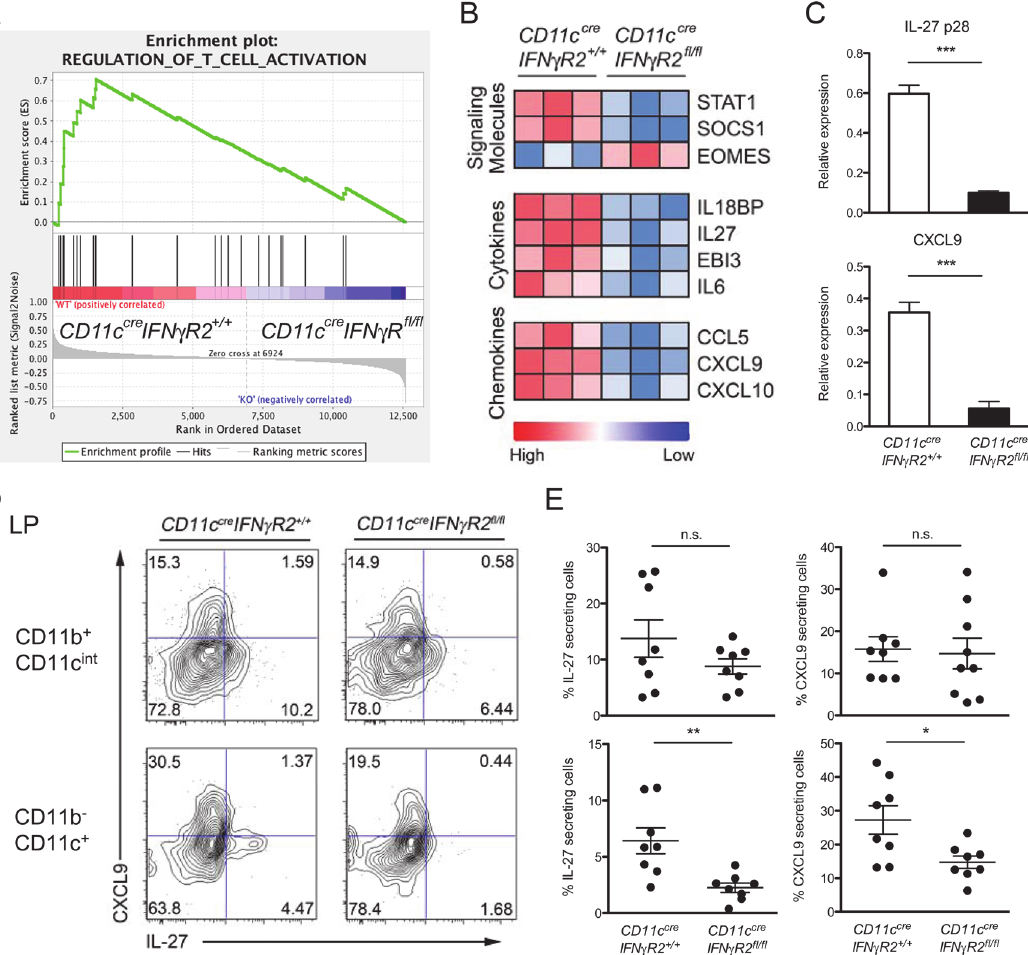
Fig 5. IFN γ R2-deficient DCs failed to produce IL-27 as well as other molecules potentially important for Th1-Treg cell differentiation during T . gondii infection. (A) GSEA of T cell activation pathway genes (GO:0050863) between IFN γ R2-deficient and — sufficient DCs [normalized enrichment score (NES) = 1.7312976, nominal P = 0.0, false discovery rate (FDR) < 25%] 8 days post T . gondii infection. (B) Comparison of genes with significant difference (p < 0.05) is shown of normalized expression values of candidate Th1-associated genes. Data are row normalized and presented as a heat map. (C) Expressions of IL-27(p28) and CXCL9 are further confirmed and quantified by qRT-PCR. (D) FACS analysis and (E) frequencies of CXCL9 + or IL-27 + CD11b + CD11c int or CD11b - CD11c + cells in LP isolated from indicated mice 8 days post T gondii infection. Data are representative of three independent experiments ( * p < 0.05; ** p < 0.01; *** p <